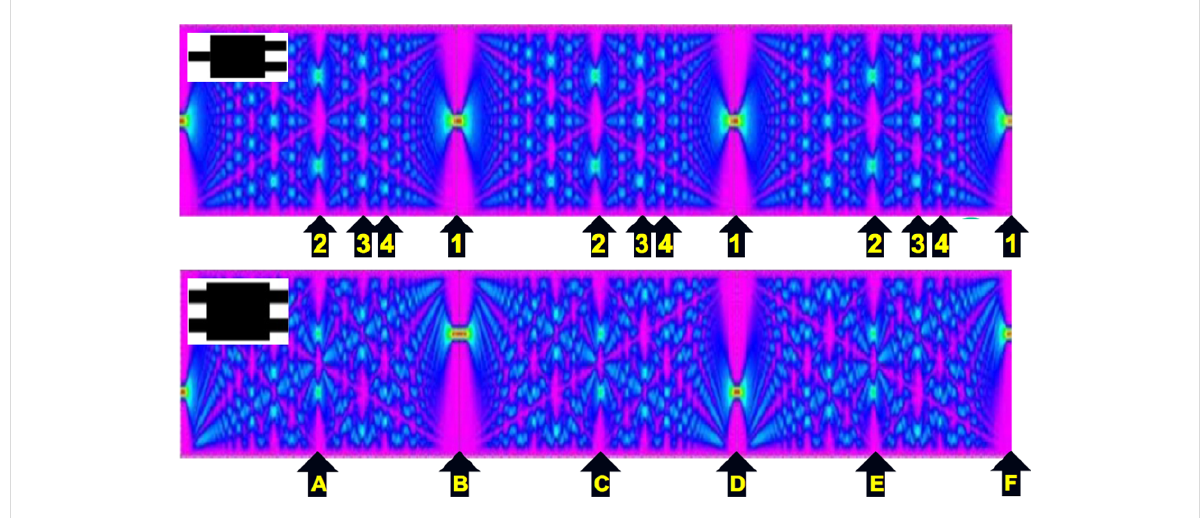
Figure 4: Power density distribution in the first three periods (3 L π ) of a 1 × 1 symmetric MMI and a 2 × 2 asymmetric MMI (insets, top left). The arrows in the top figure are effective device lengths where 2, 3, 4, and 1 outputs show up on each period (there are several solutions). The arrows in the bottom figure are effective lengths where the device behaves as a 50:50, a 100:0, and a 0:100 coupler. One can switch between these lengths modi- fying the refractive index of the LC cladding. This produces several tunable